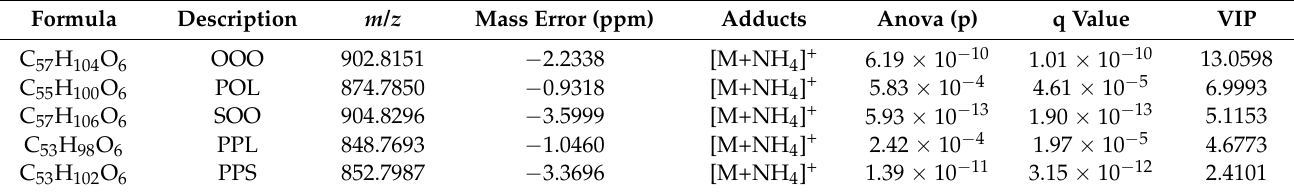
Table 2. Markers identified in different processing methods of camellia